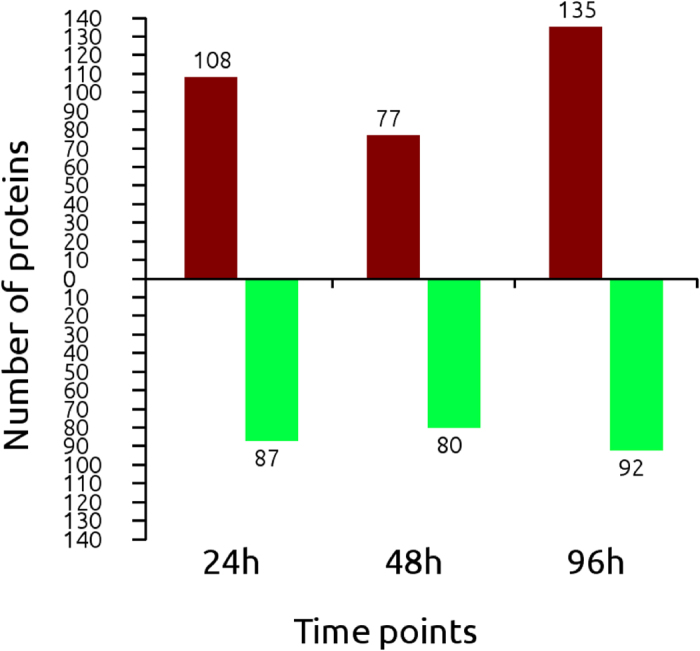
Number of differential expressed proteins detected at 24, 48 and 96 h.